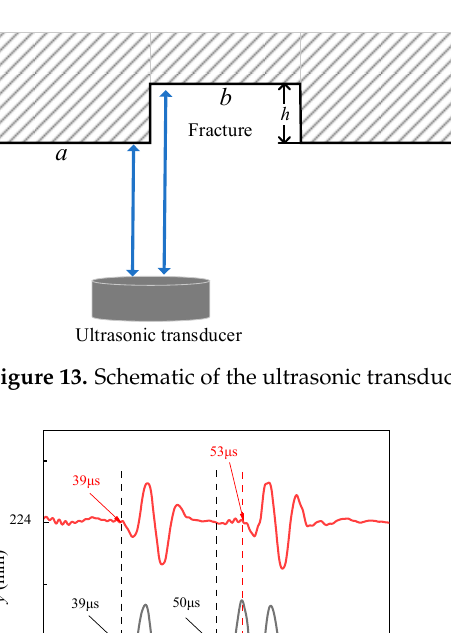
8 of 17 Figure 12. Measurement waveforms at the same height of grooved sandstone Plate 2. When the simulated fracture in Figure 13 was encountered during measurement, the ultrasonic transducer received the echo reflected by the two surfaces a and b , where sur- face a is the sample surface and b is the bottom surface of the groove. The dominant fre- quency of the ultrasonic transducer is 250 kHz, the longitudinal wave speed in water is